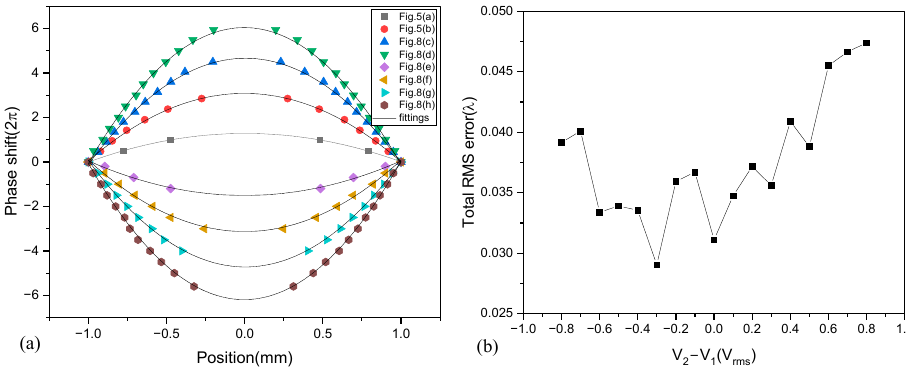
izontal axis of the lens, the results of which are shown in Figure 9a. The symbols are meas ‐ urements and the curves are parabolic fittings. The phase profiles follow almost parabolic profiles in the whole focus range. The total root ‐ mean ‐ square (RMS) errors of the wave ‐ front are then extracted and are shown in Figure 9b. It can be seen that both positive and negative lenses have a very small RMS error. The positive lens has an RMS maximum around 0.047 λ , while it is 0.040 λ for the negative lens.